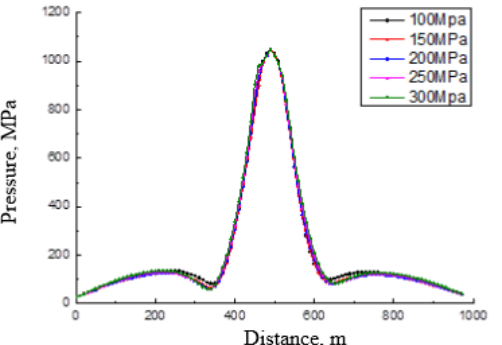
Figure 23. Cloud map of finite element calculation results. ( a ) Rock compressive strength 100 MPa, ( b ) rock compressive strength 150 MPa, ( c ) rock compressive strength 200 MPa, ( d ) rock compres- sive strength 250 MPa, ( e ) rock compressive strength 300 MPa.